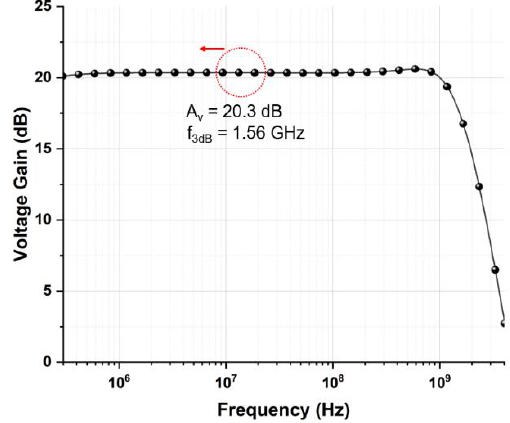
Figure 7. Simulated frequency response of the proposed limiting amplifier (LA).